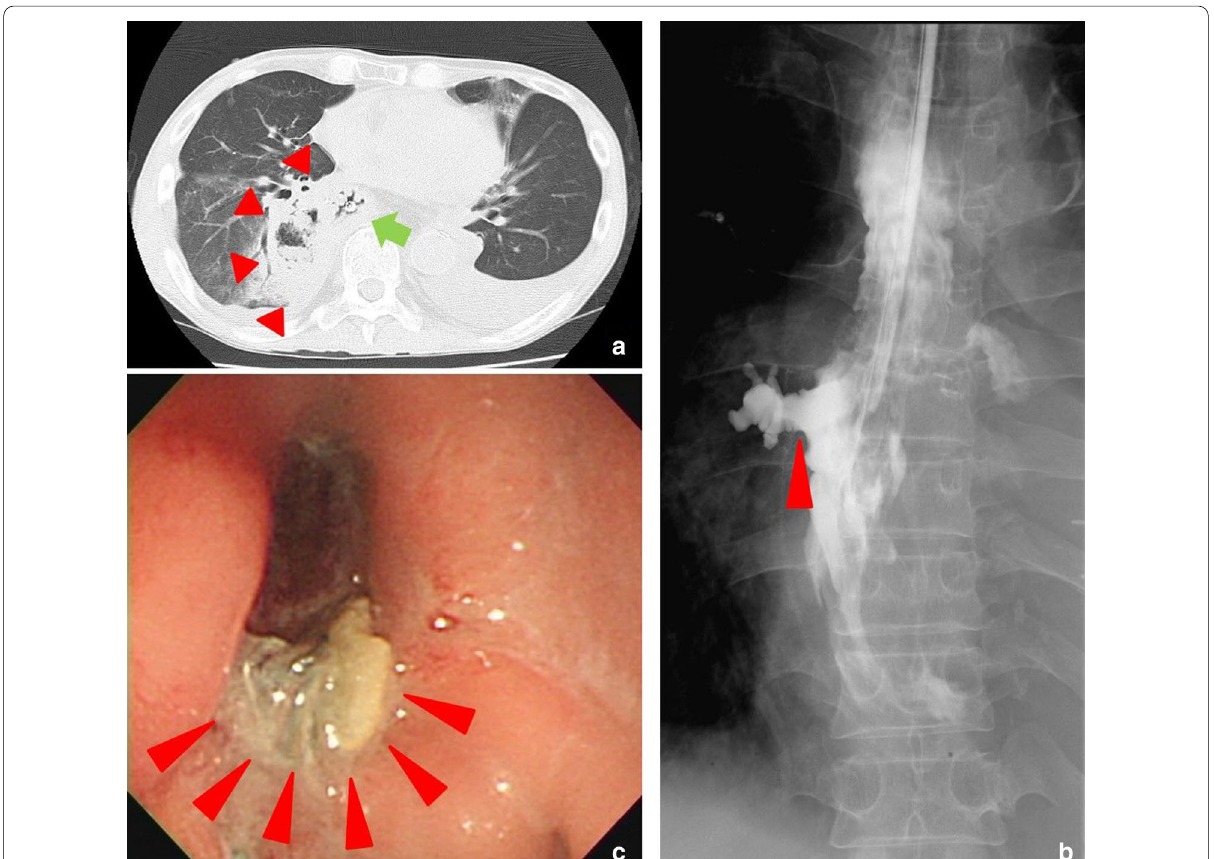
Fig. 1 Imaging examinations of the fistula and pulmonary abscess performed before the conservative treatment. a A CT image showed a cavity with an air bubble on the right side of the gastric staple line. The green arrow indicates the gastric tube, and the red arrowheads show the abscess. b A Gastrografin esophagram showed extravasation into the right side of the thoracic cavity (red arrowheads). c An endoscopic examination confirmed that the fistula was located on the anal side of the anastomotic site. The red arrowheads indicate the